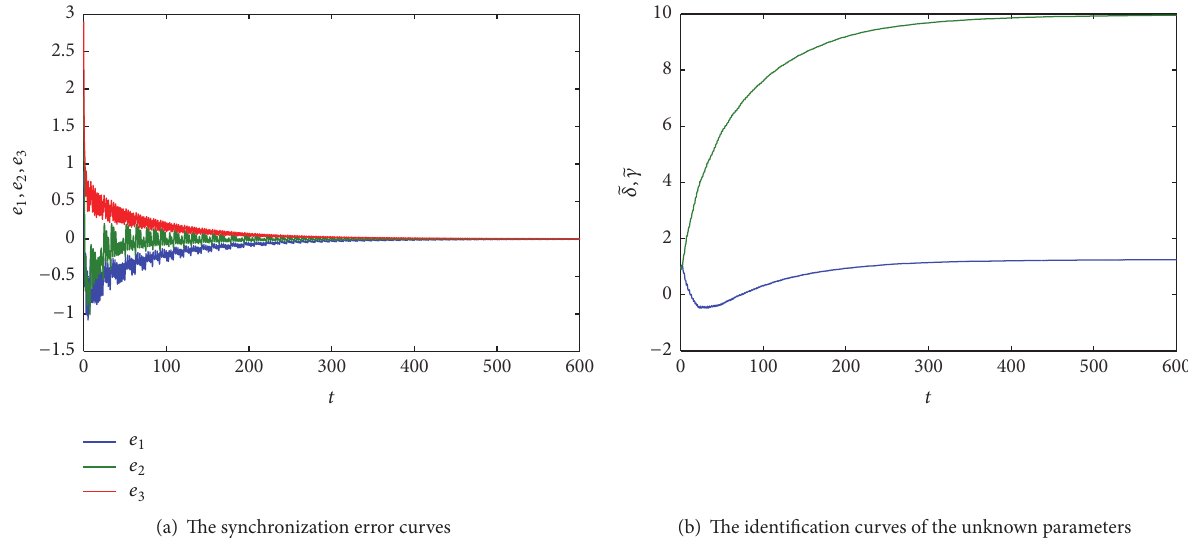
Figure 9: The synchronization results of the numerical